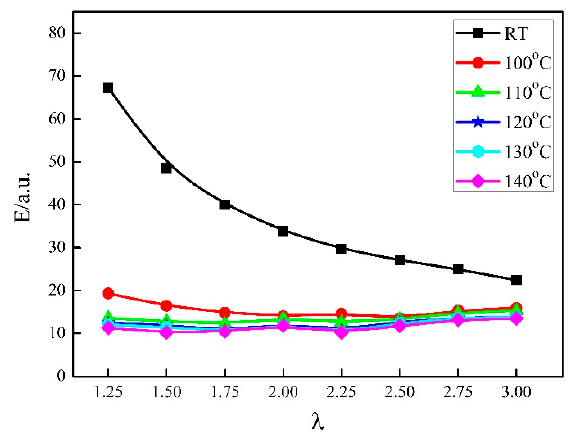
Figure 9. Young’s modulus of γ -PA1010 di ff erent draw Figure 9. Young's modulus of γ -PA1010 different draw ratios.